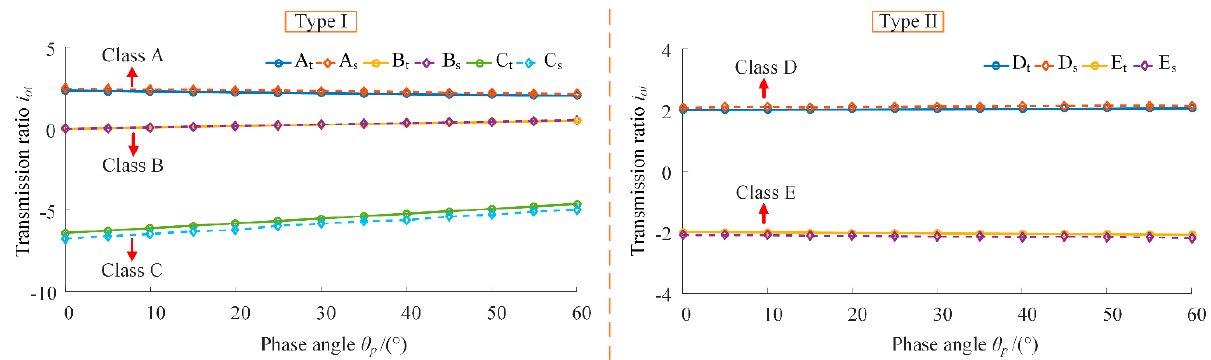
Figure 15. Comparison between theoretical and simulation results of overall transmission ratio.